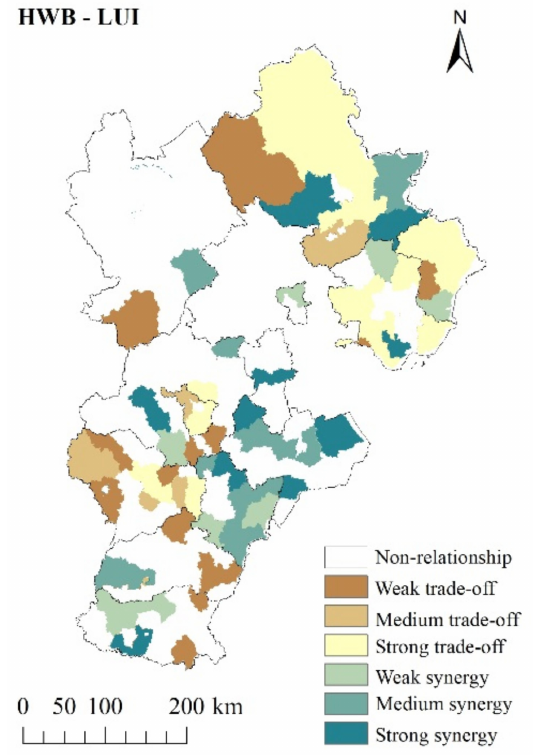
Figure 8. The distribution of trade-offs/synergies between LUI and HWB in Hebei during 2000–2015. Table 7. The proportion of trade-off/synergy area between LUI and HWB in Hebei during 2000–2015. HWB-LUI